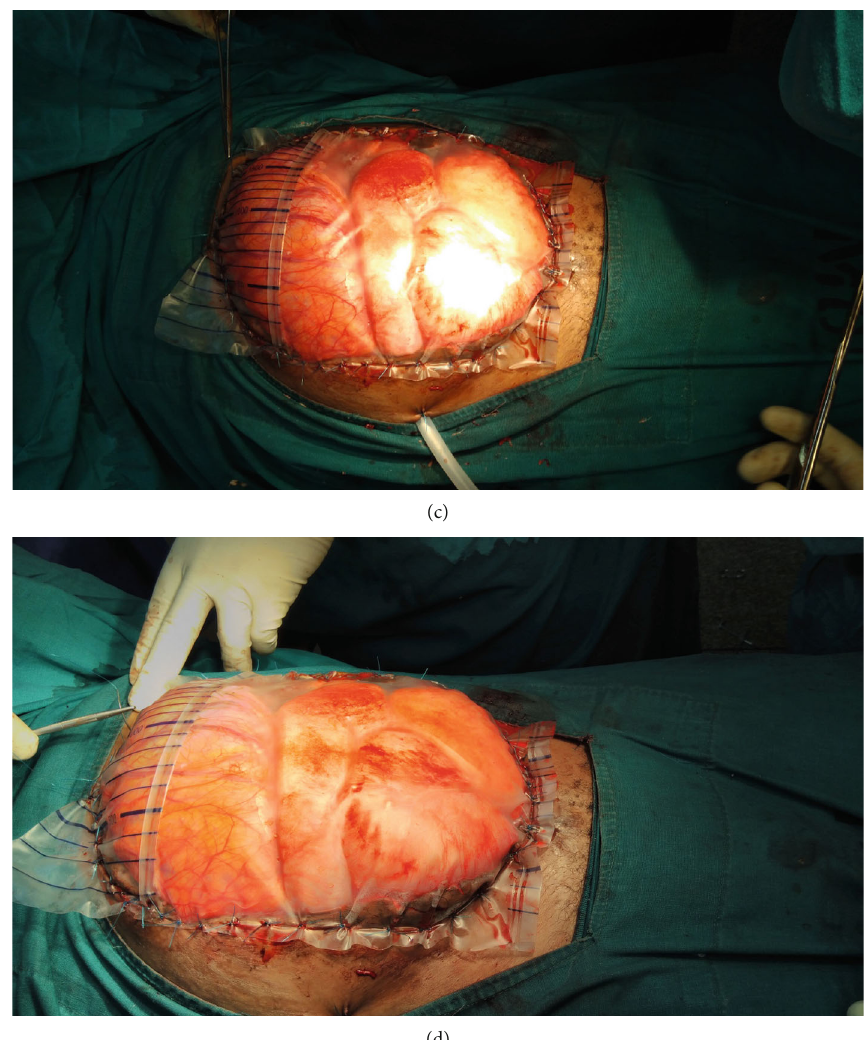
Figure 1: Standard urine collection bag sutured over anterior abdominal wall incisional wound exposing oedematous bowels with abdominal drain in